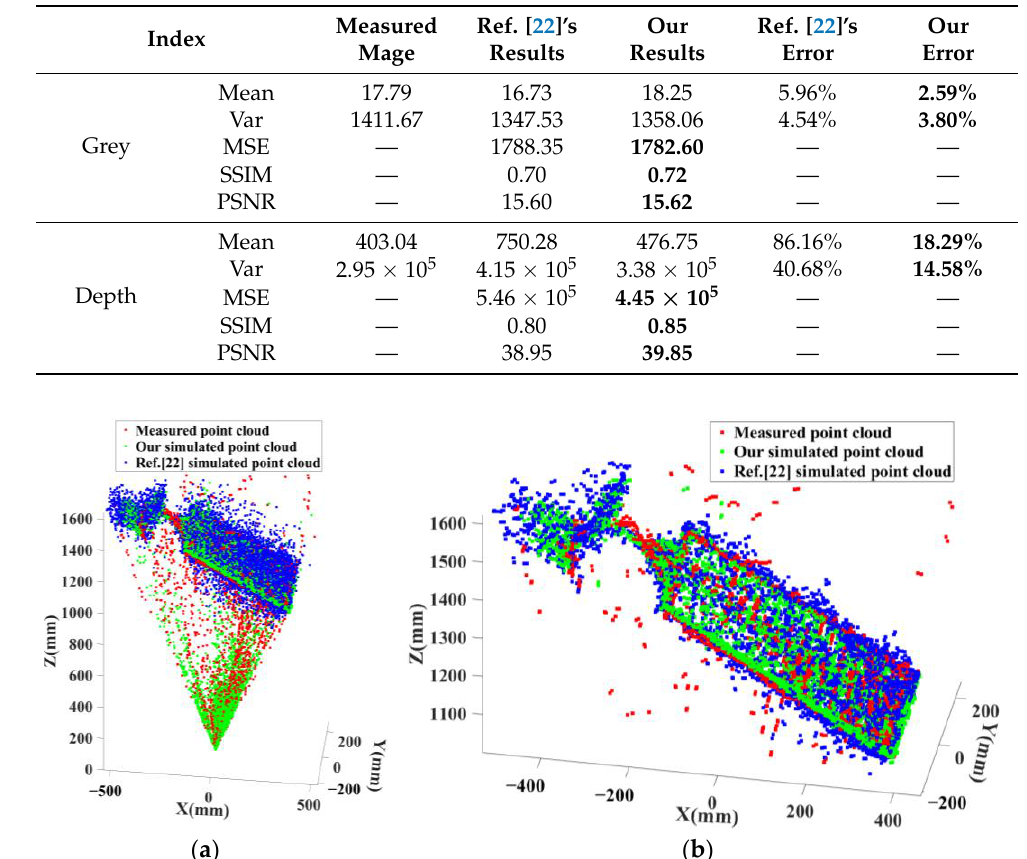
Table 5. Comparison of indexes between measured images and simulated images.